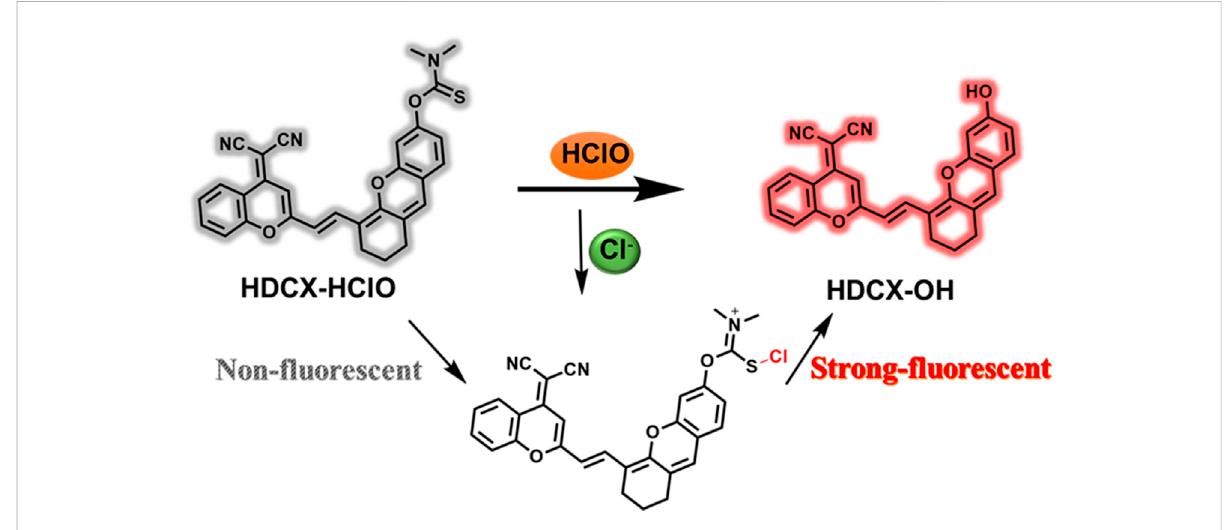
FIGURE 1 Sensing mechanism of HDCX-HClO to